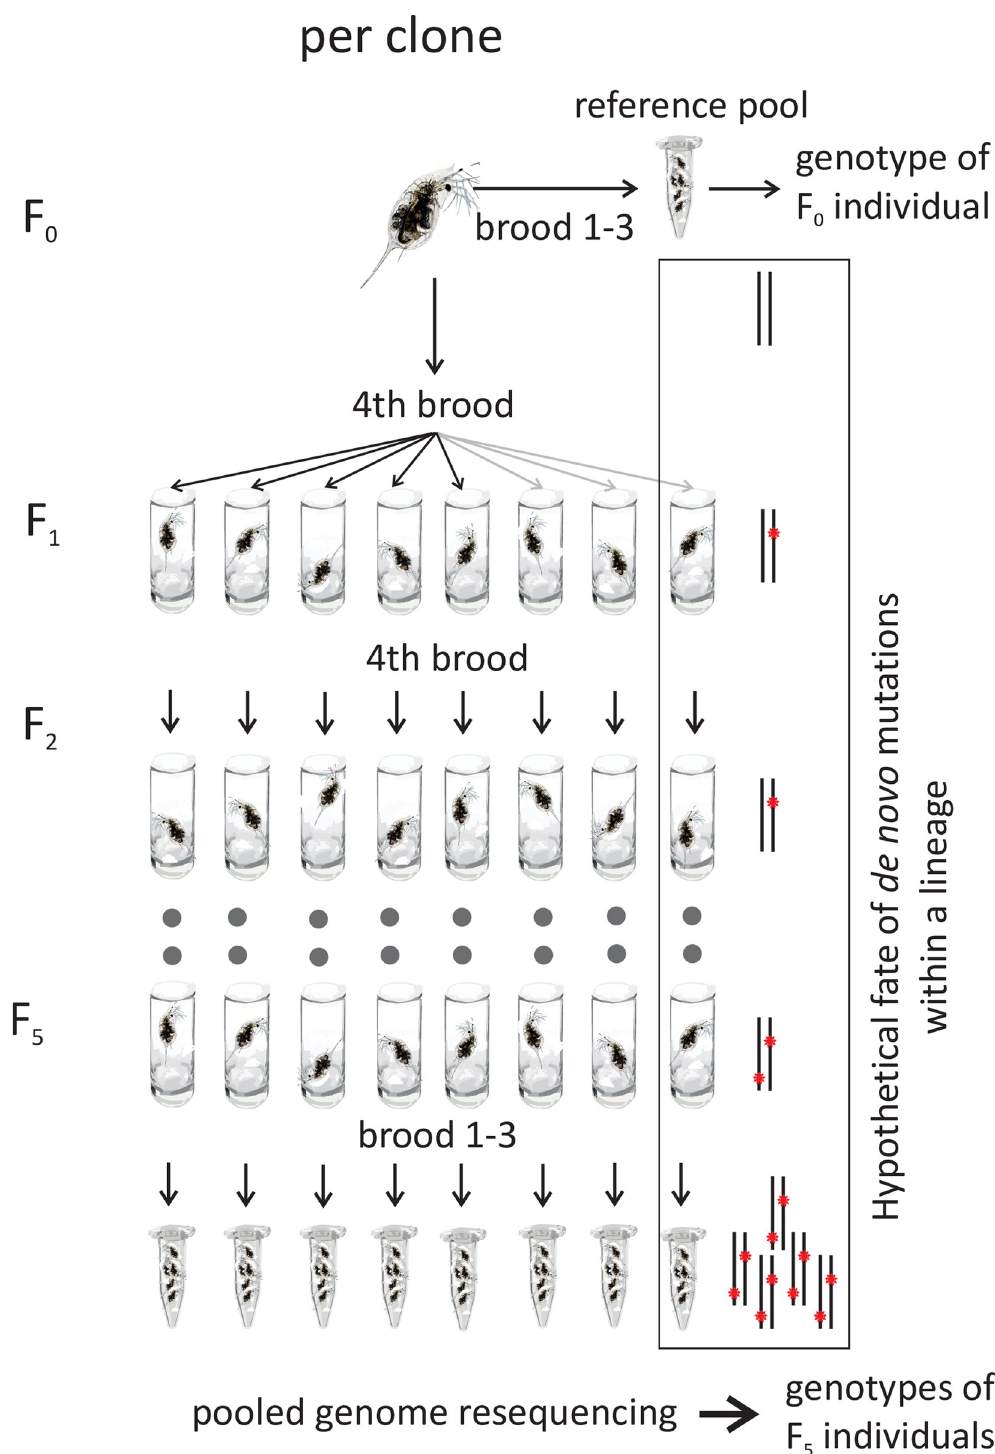
Fig 1. Schematic experimental set-up for the short-term mutation accumulation lines per clone. The fate of hypothetic de novo mutations for a single lineage is sketched in the box on the right.